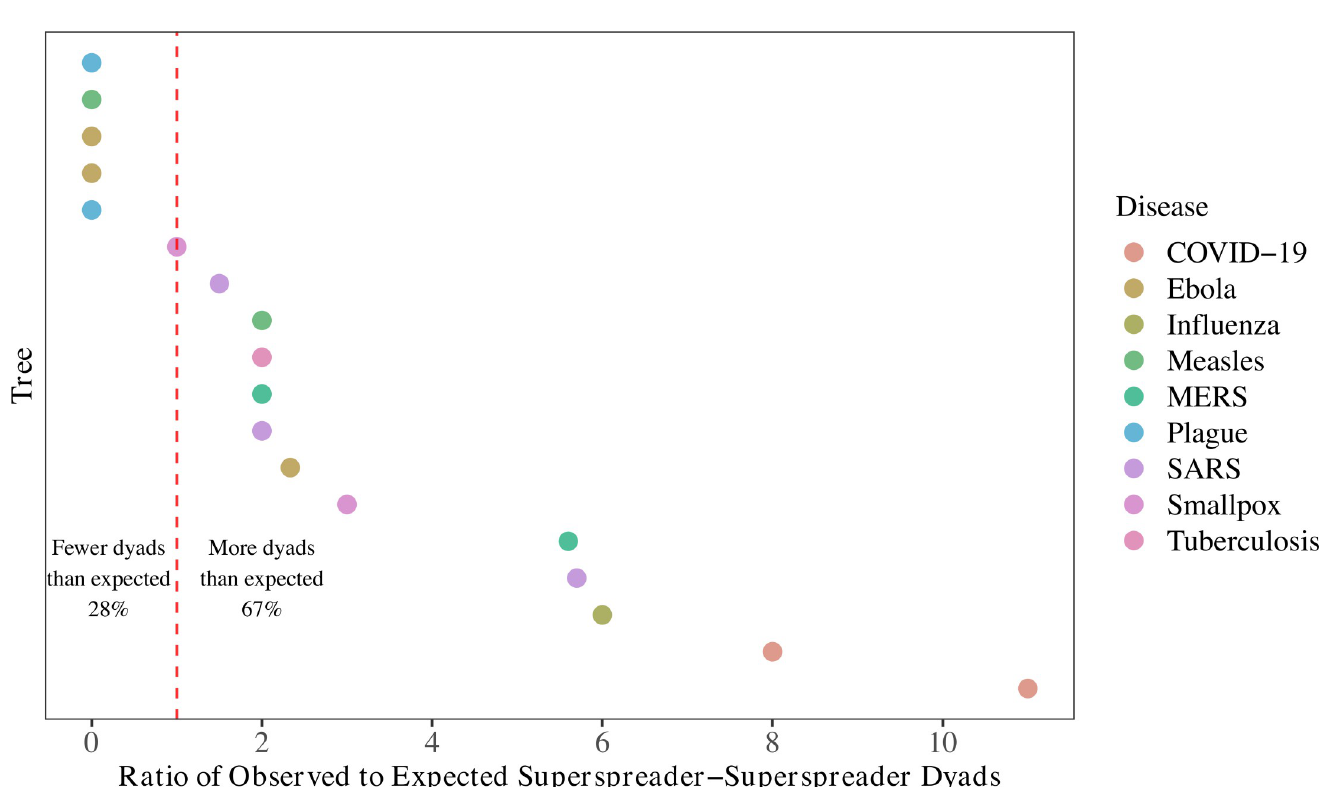
Fig 5. In two-thirds of transmission trees, superspreaders infect superspreaders more often than would be expected by chance. The expected number of superspreader-superspreader dyads was calculated by s ð s (cid:0) 1 Þ for each tree, where s is the number of superspreaders in the tree, t is the number of terminal nodes (nodes S (cid:0) t that do not cause onward transmission), and S is tree size. Ratios larger than 1 indicate more superspreader-superspreader dyads were observed than would be expected by chance. This analysis was limited to trees with more than 1 superspreader, 20 or more cases, and 2 or more generations of spread. We assumed tree completeness here, but results assuming incompleteness are shown in S7 Fig. The data to reproduce this figure can be found at https://doi.org/10.5061/dryad. nk98sf7w7. COVID-19, Coronavirus Disease 2019; MERS, Middle East Respiratory Syndrome; SARS, Severe Acute Respiratory